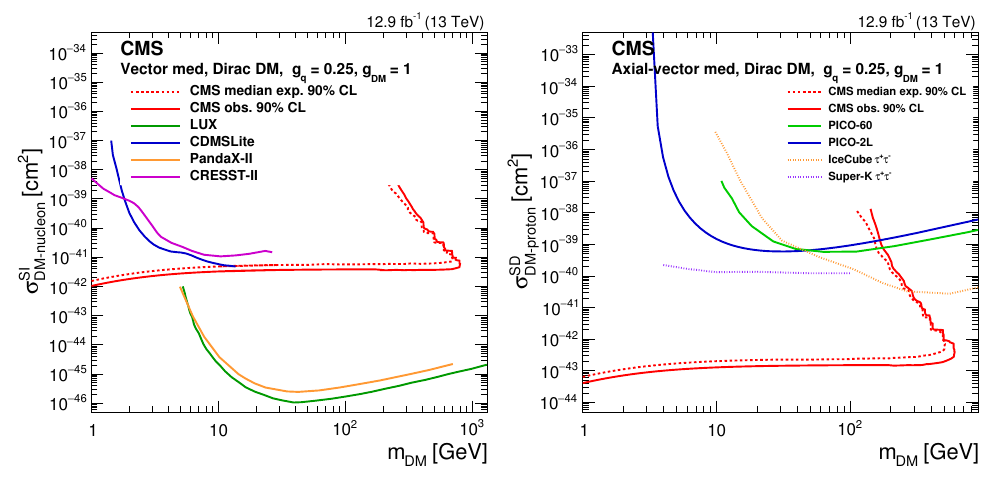
Figure 11 . Exclusion limits at 90% CL in the m DM vs. (cid:27) SI/SD plane for vector (left) and axial- vector (right) mediator models. The solid (dotted) red line shows the contour for the observed (expected) exclusion in this search. Limits from the CDMSLite [91], LUX [92], PandaX-II [93], and CRESST-II [94] experiments are shown for the vector mediator. Limits from the PICO-2L [95], PICO-60 [96], IceCube [97], and Super-Kamiokande [98] experiments are shown for the axial-vector mediator.